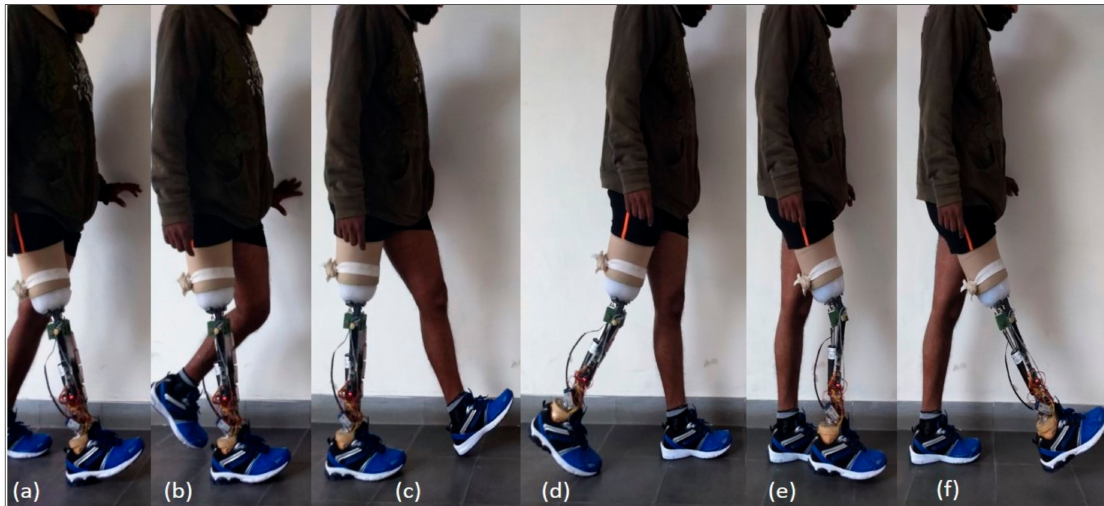
Figure 7. Photograph of subject with developed prosthesis during training in segment ( a ) loading response, ( b ) mid-stance, ( c ) terminal-stance, ( d ) pre-swing, ( e ) extended knee in swing, and ( f ) fully flexed knee in